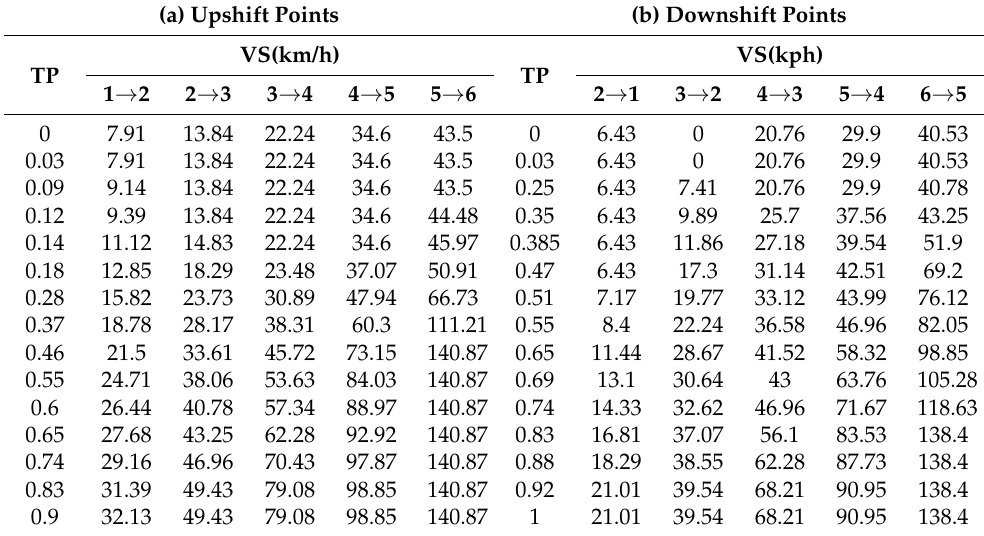
Table 1. Example of shift schedules: Vehicle speed (VS) and throttle position